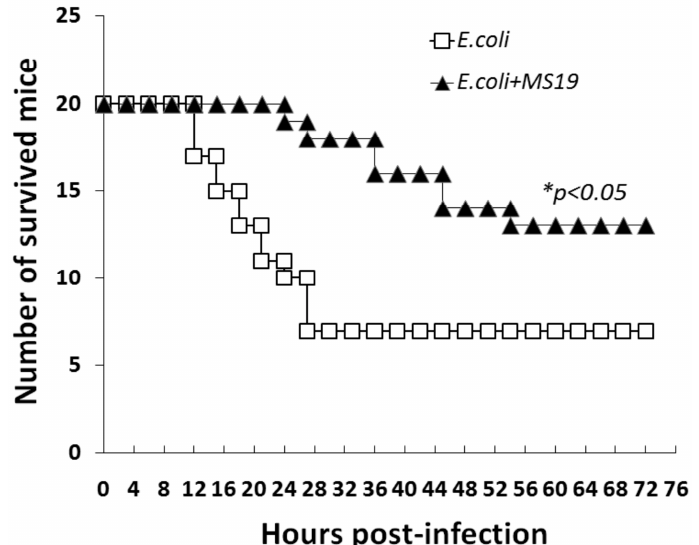
Figure 1. Survival curves of mice with septic peritonitis induced by Escherichia coli ( E. coli .) 40 specific pathogen-free female Institute of Cancer Research (ICR) mice (20 ± 2 g) of eight-week-old were intraperitoneally injected with E. coli at 1.6 × 10 8 Colony-Forming Units (CFUs). At 1 h post infection, the mice were intraperitoneally administrated with ( E. coli + MS19, n = 20) or without ( E. coli , n = 20) MS19 (10 µg/mouse) once. The mice were observed for 72 h for recording their survivals. * p < 0.05.